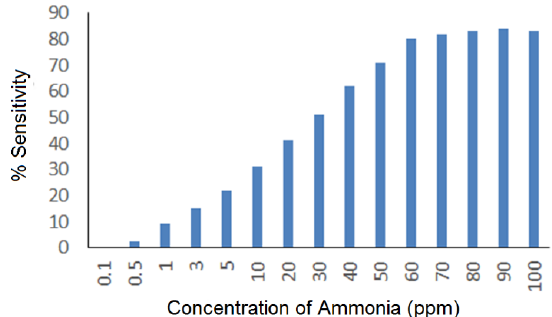
Figure 7. Sensitivity of the In 2 O 3 nanoparticle sensor at different concentrations of ammonia.